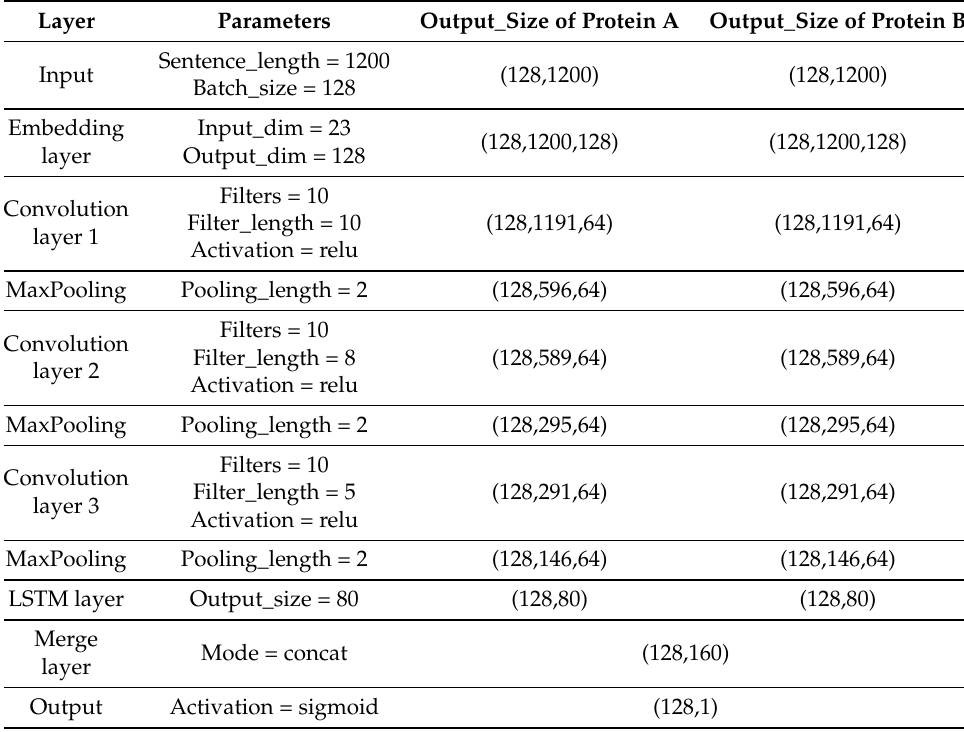
Table 4. The parameters and output sizes of each